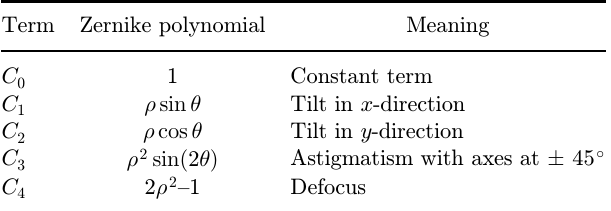
Fig. 1. Illustration of eye's TCA and LCA in the image and object spaces. The dotted line represents red light, while the solid line represents near-infrared light. LCAs in the (a) image and (b) object spaces. TCAs in the (c) image and (d) object spaces. Table 1. Zernike coe±cients, C 0 – C 4